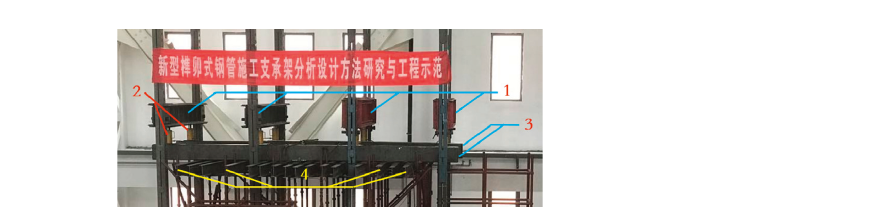
Figure 5: Loading device. (1) Counterforce frames; (2) hydraulic jacks; (3) box-type distribution beams; (4) 20a-type joist steels. Table 3: Loading system in different experimental